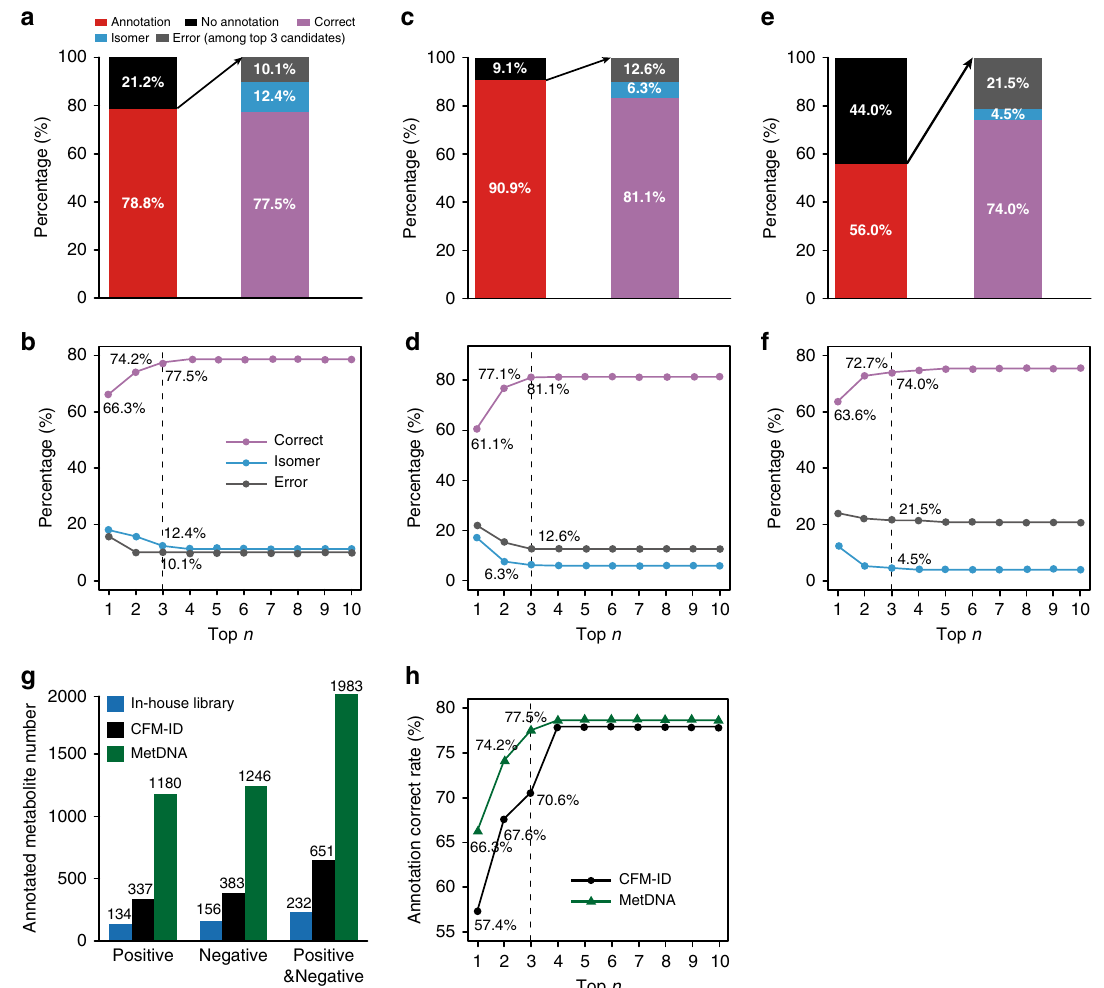
Fig. 3 Validation of high annotation accuracy from MetDNA and the comparison with CFM-ID. a , b Validation of metabolite annotations from MetDNA by spiking 200 metabolite standards into mouse liver samples. c , d Validation of metabolite annotations using the con fi rmed seed metabolites in the Drosophila aging datasets. e , f Validation of metabolite annotations in Drosophila aging datasets from MetDNA using external NIST and MassBank spectral databases. a , c , e Statistics of the annotation coverage, and correct, isomer, and error rates among the top three candidates; b , d , f statistics of correct, isomer, and error rates among top n ( n = 1 to 10) annotations. The x -axis represents the top n ( n = 1 – 10) metabolite candidates for each peak. The y -axis represents the percentages for correct (purple), isomeric (blue), and erroneous (black) annotations. g The numbers of annotated metabolites using in-house library, CFM-ID, and MetDNA in Drosophila aging datasets. h Comparison of annotation correct rates between CFM-ID and MetDNA in the